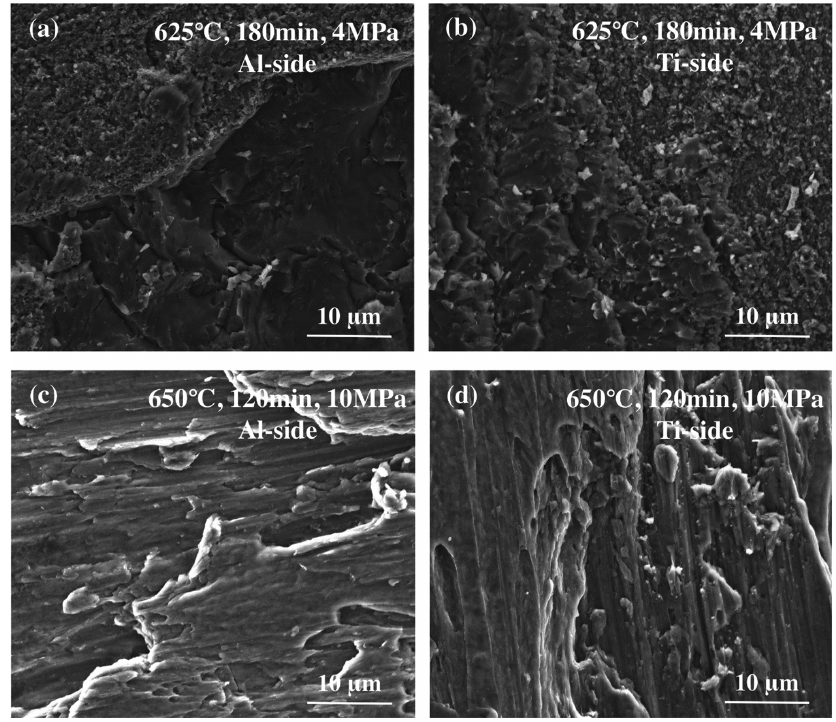
Figure 11: Shear fractographs of the Ti/Al diffusion joints obtained at different processing